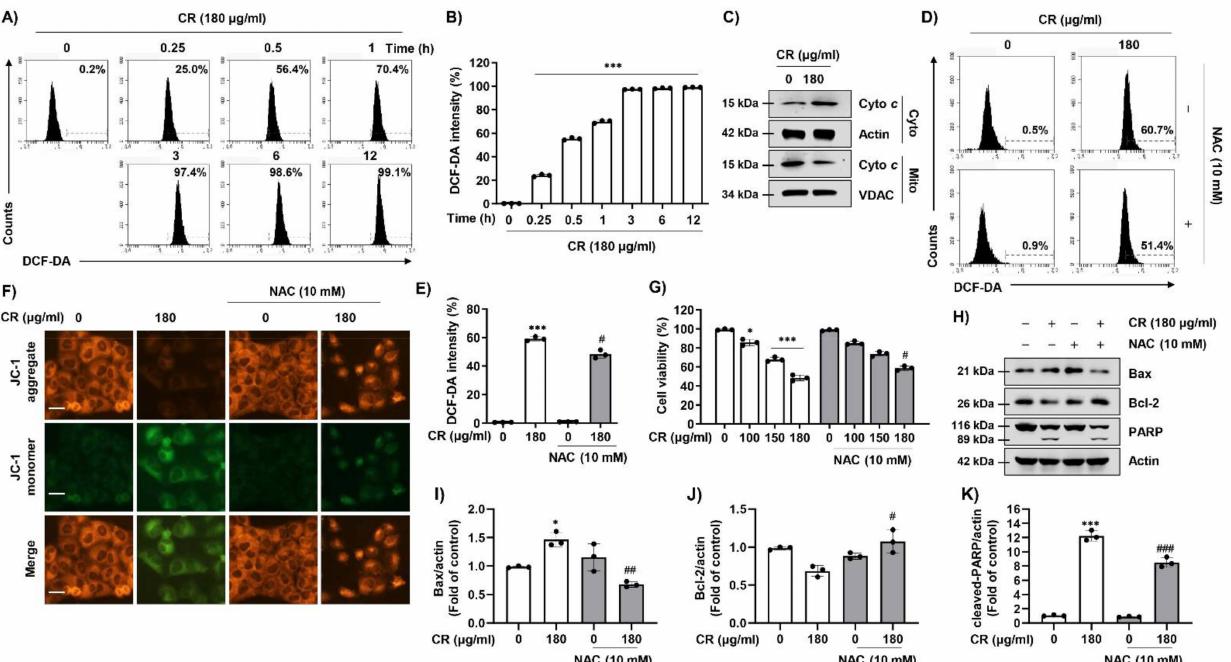
Figure 2. ROS regulates CR-mediated apoptosis in Hep3B cells. ( A ) Cells were treated with 180 µ g/mL CR for the indicated times and cells were treated with 2 (cid:48) ,7 (cid:48) -dichlorofluorescein diacetate (DCF-DA) staining solution for 20 min at 37 ◦ C. Cells were washed with PBS and collected. The levels of ROS were measured by a flow cytometer. ( B ) The levels of ROS were presented as a quantification of fluorescence intensity ( n = 3). *** p < 0.001 compared to control. ( C ) Cells were treated with 180 µ g/mL CR for 24 h and harvested and then mitochondrial and cytosolic proteins were isolated by a mitochondria isolation kit. The equal amounts of proteins were performed Western blot analysis to detect. Actin was used as a loading control. ( D , E ) Cells were pre-treated with or without 10 mM of N -acetylcysteine (NAC) for 1 h, and then cells were treated with 180 µ g/mL CR. After 1 h, cells were stained with DCF-DA for 20 min and measured ROS levels, quantitated using a flow cytometer. Data are expressed as the mean ± SD ( n = 3). *** p < 0.001 compared to control, and # p < 0.05 compared to CR-treated cells. ( F – H ) After 24 h of CR treatment, cells were incubated with of 5,5 (cid:48) 6,6 (cid:48) -tetrachloro-1,1 (cid:48) ,3,3 (cid:48) -tetraethyl- imidacarbocyanine iodide dye (JC-1) for 20 min, and the fluorescence intensity of JC-1 was observed with a fluorescence microscope. Scale bars; 30 µ m. ( G ) After 24 h of CR treatment, the cell viability was measured by the MTT assay. Data are expressed as the mean ± SD ( n = 3). * p < 0.05 and *** p < 0.001 compared to control, and # p < 0.05 compared to CR-treated cells. ( H ) Cells were pre-treated with or without NAC for 1 h and then treated with 180 µ g/mL of CR for 24 h. Cells were lysed, and equal amounts of proteins were analyzed using Western blot analysis. The expression of apoptosis-related proteins (Bax, Bcl-2, and PARP) were detected by Western blotting. Actin was used as a loading control. ( I – K ) Bar graphs indicate the relative band density in Western blot analysis ( n = 3). * p < 0.05 and *** p < 0.001 compared to control; # p < 0.05, ## p < 0.01, and ### p < 0.001 compared to CR-treated